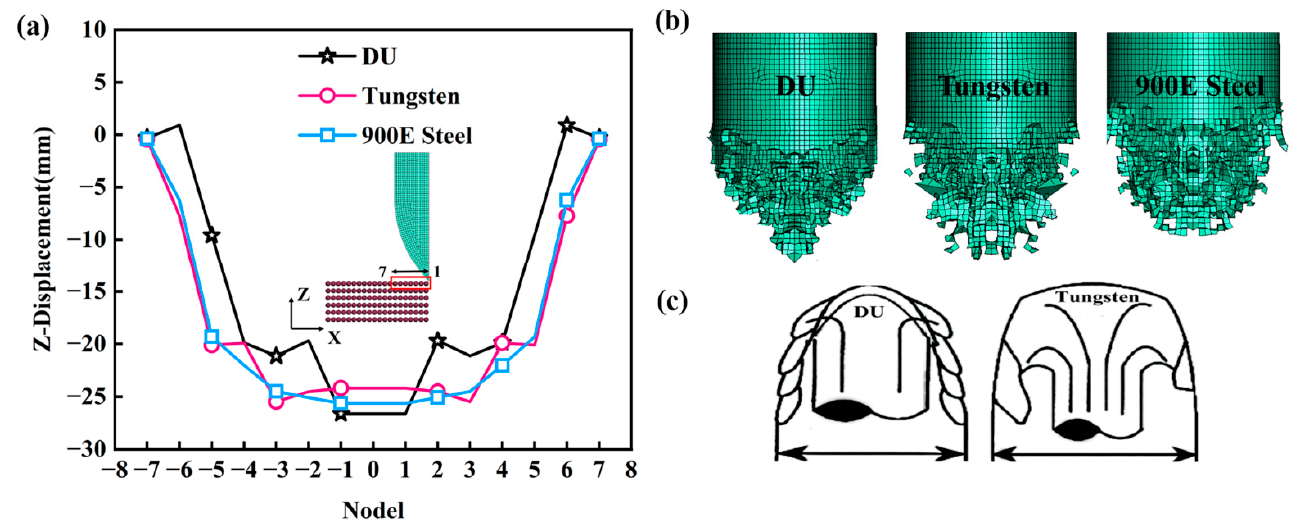
Figure 5. Displacement changes of surface nodes along the impact direction during penetration of different alloys. ( a ) Node displacement distance; ( b ) Comparison of the shape of the bullet after penetration; ( c ) Tip deformation of depleted uranium and tungsten alloy amour piercing warheads [20].